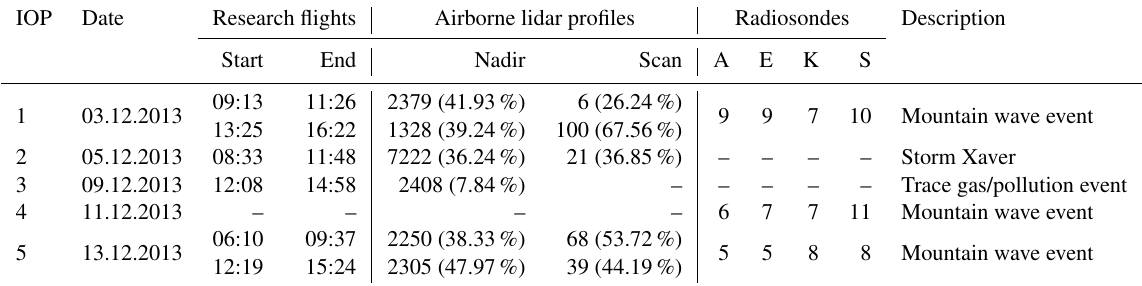
Table 1. Overview of intensive observation periods (IOPs) during GW-LCYCLE I. Start and end times of research flights are indicated inUTC. For each flight the number of airborne lidar profiles in both nadir and scanning mode (see Sect. 2.2) and the corresponding coverage of useable data in percentage is shown. Radiosondes were released at Andenes (A), Esrange (E), Kiruna (K) and Sodankylä (S) (see Fig. 1). IOP Research flights Airborne lidar